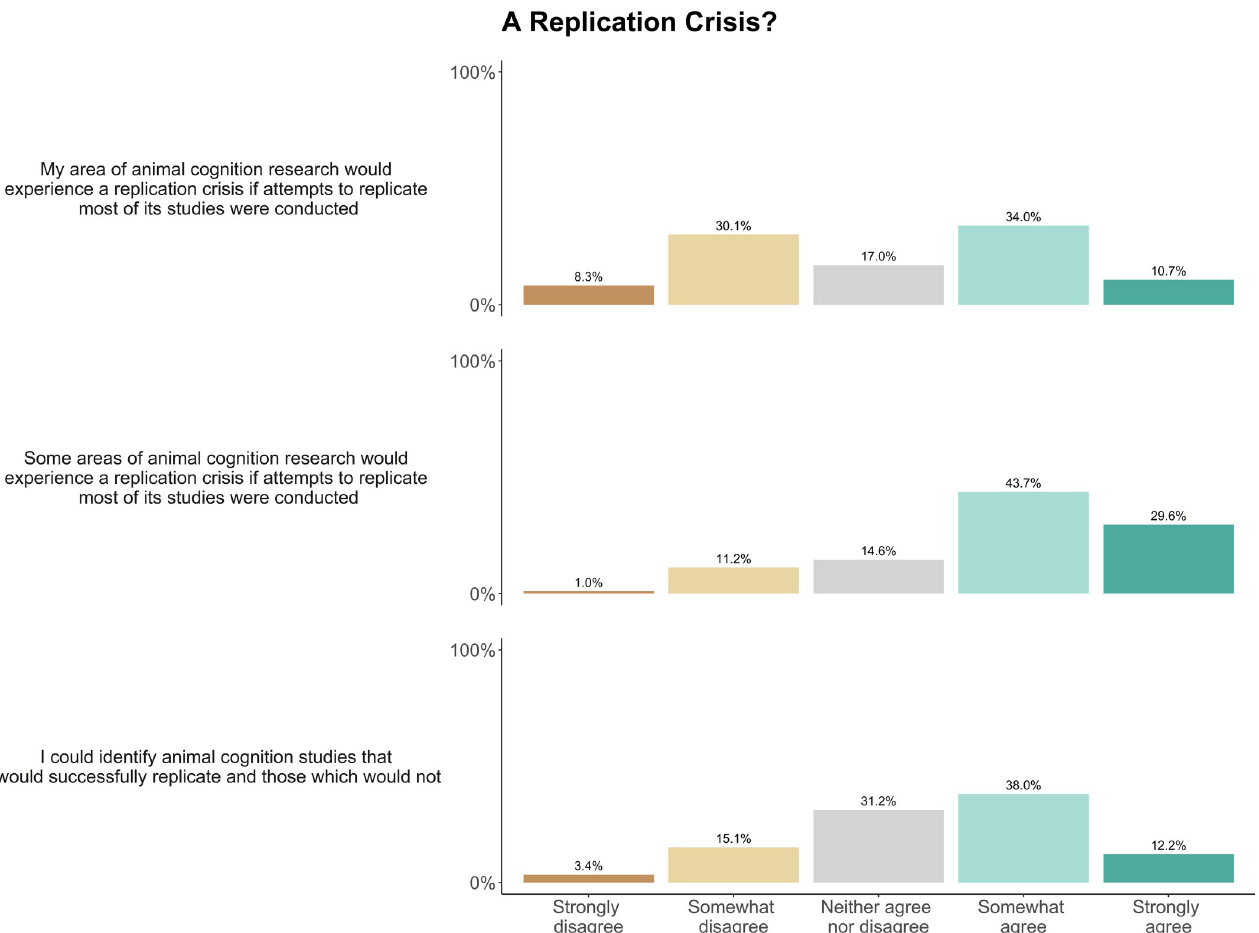
Fig 14. Animal cognition researchers’ perceptions of a replication crisis in the discipline, and their ability to identity studies that would not replicate, N =